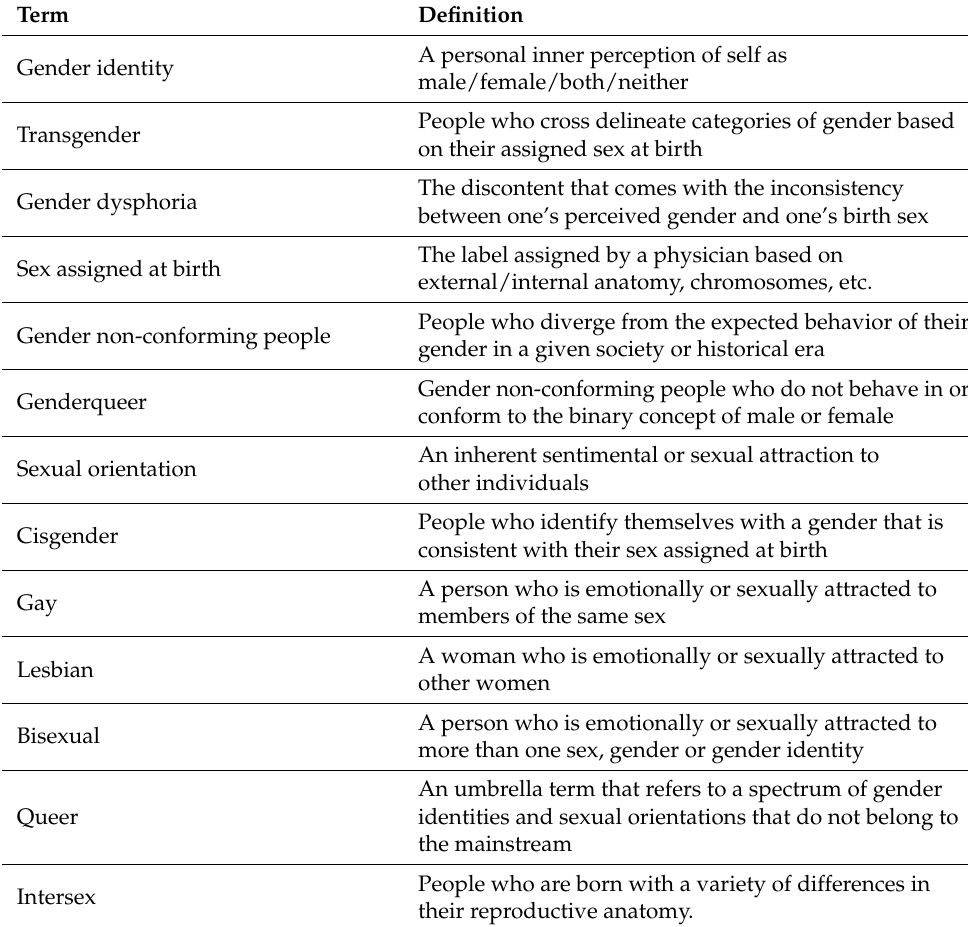
Table 1. LGBTQ+-related